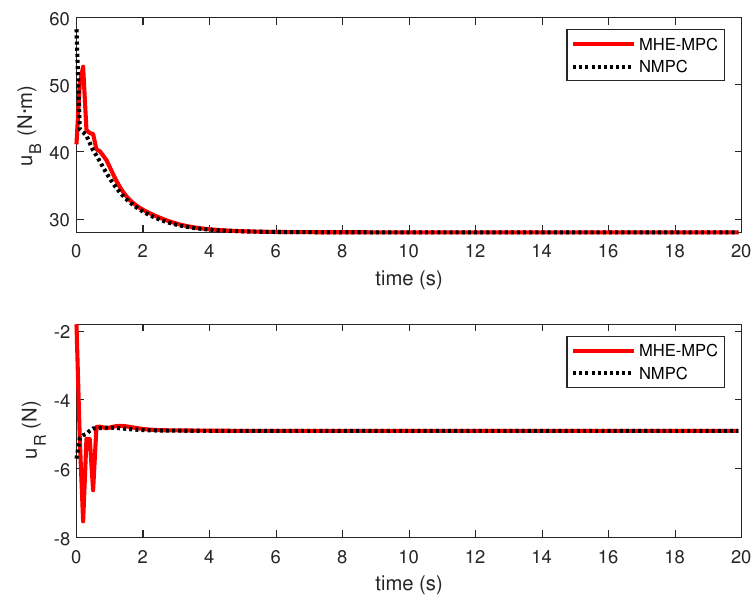
Figure 7. Case 1: control inputs u B and u R .